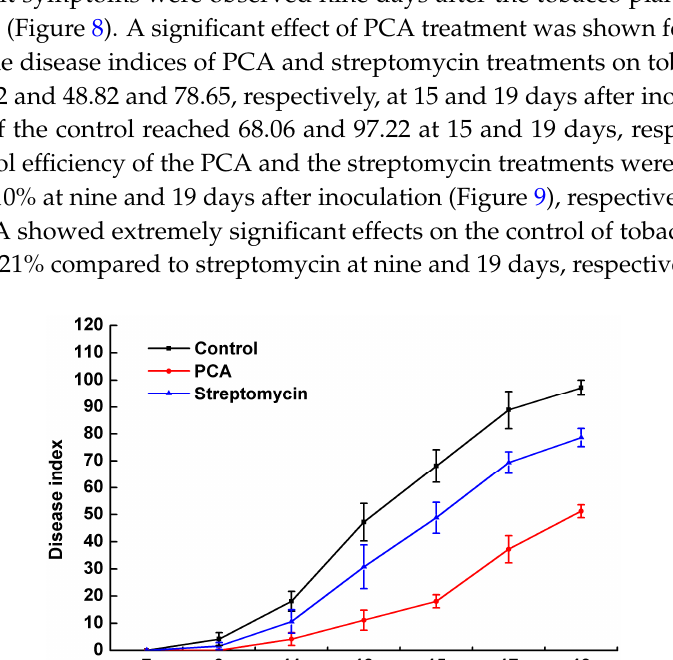
Figure 8. Disease index of bacterial wilt of tobacco with PCA treatment. Unwounded tobacco plants were soil-soak inoculated at concentrations of 5 mL (1 × 10 8 cfu/mL) and inoculated at 28 ± 1 °C after treatment with 40 μ g/mL PCA. Untreated plants were treated with sterile water. The mean of three replications and the data were from a single representative and reproduced several times. The disease index was expressed as the mean ± SE.